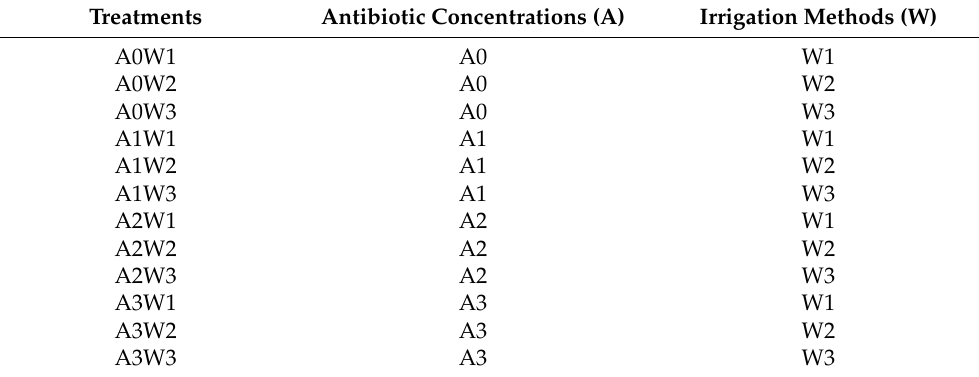
Table 1. Processing numbers. Treatments Antibiotic Concentrations (A) Irrigation Methods